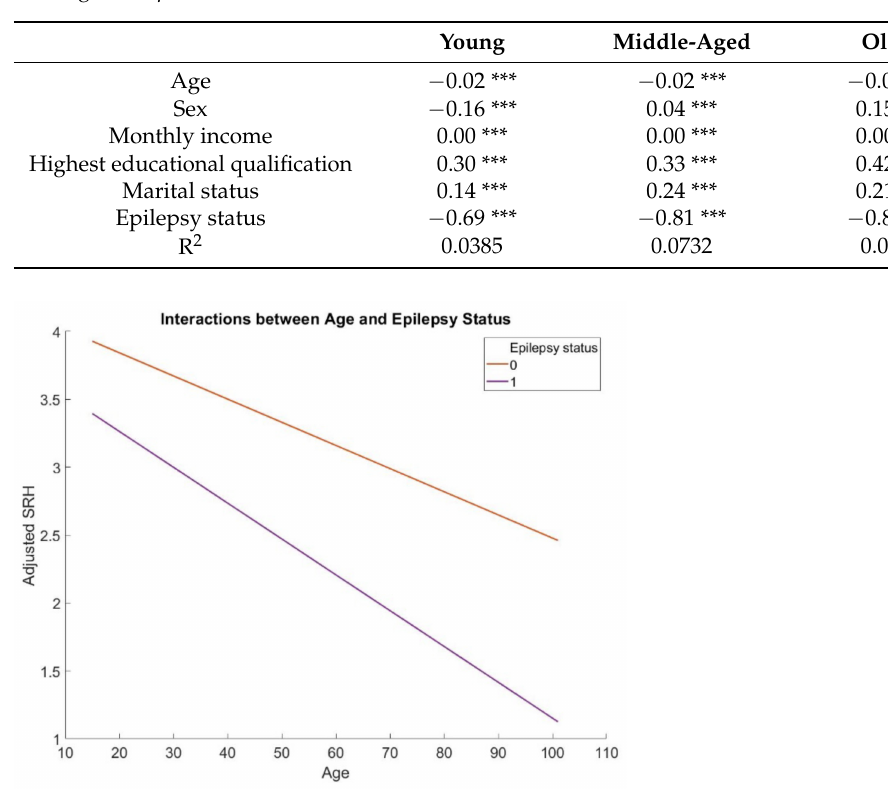
Table 2. The regression coefficient ( b ) for the demographics and epilepsy status with the total explained variances (R 2 ) for young, middle-aged, and older people. All numbers were rounded up to two digits. *** p < 0.001.